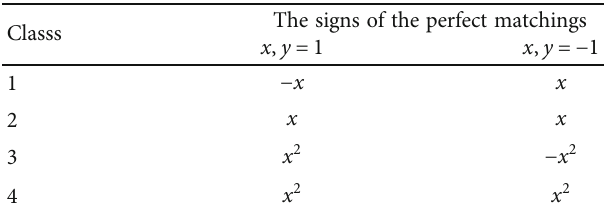
Table 1: The sign weights of perfect matchings in H